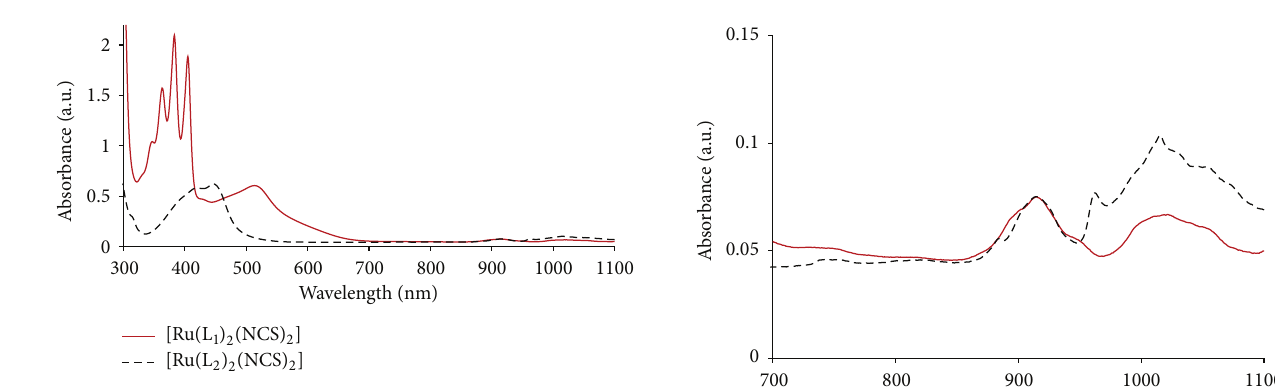
Figure 5: Comparison of the UV-V is absorption spectrum of [Ru(L 1 ) 2 (NCS) 2 ] (solid line) with [Ru(L 2 ) 2 (NCS) 2 ] (dash line) at a concentration of 1 × 10 −3 M −1 in DMF solution showing effect of extended 𝜋 -conjugation using anthracene.